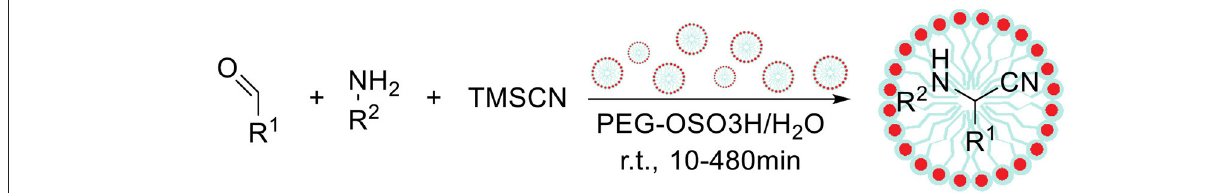
SCHEME 7 | The Strecker reaction under micellar catalysis type 2 conditions.